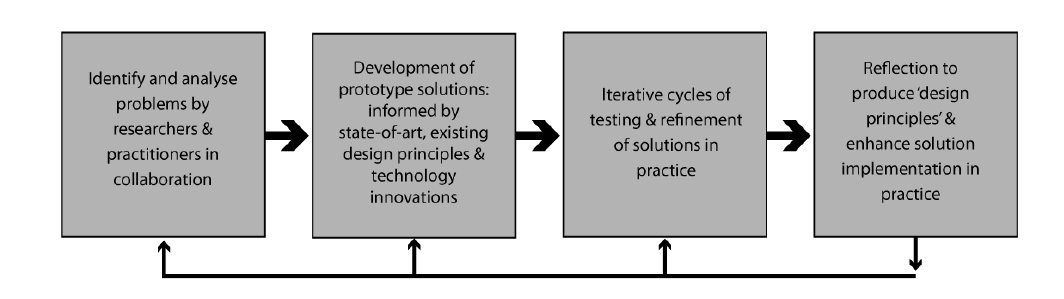
Figure 1. Stages of educational design research (Reeves, 2006, p. 59).